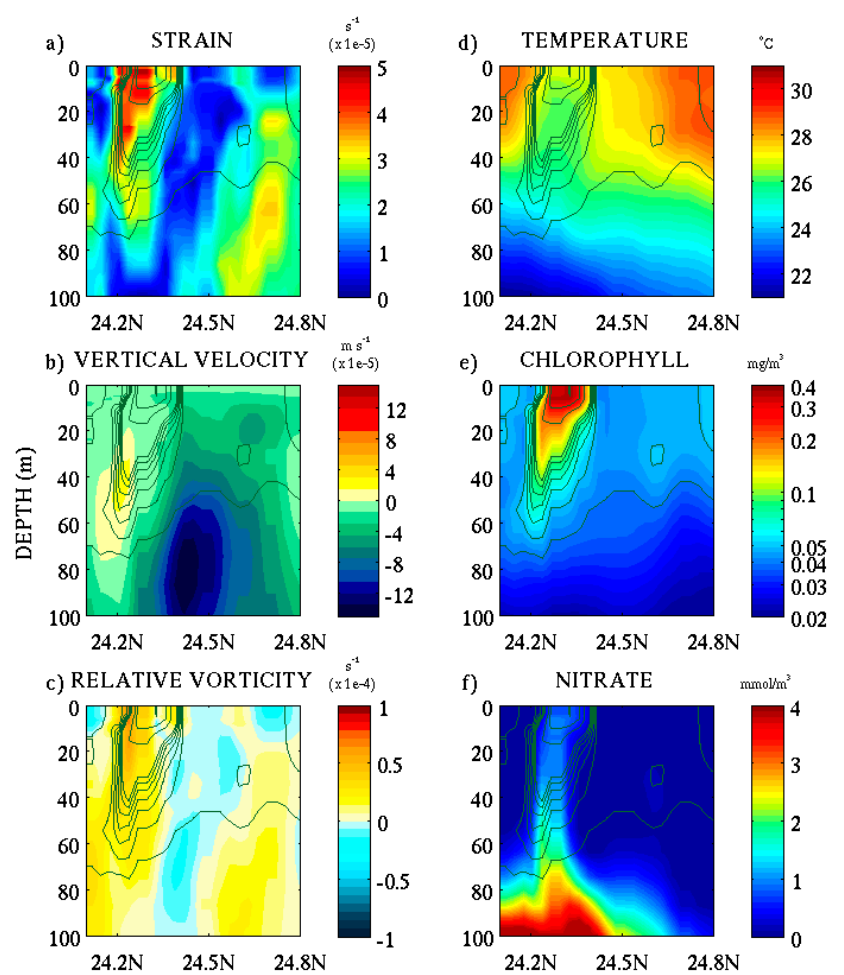
Figure 9. Simulated filament cross-section view (~89.6 ° W), outer filament edge 21 September 2004: ( a ) strain rate (s − 1 ); ( b ) vertical velocities (m s − 1 ); ( c ) relative vorticity (s − 1 ); ( d ) temperature ( ◦ C); ( e ( a ) strain rate (s − 1 ); ( b ) vertical velocities (m s − 1 ); (c) relative vorticity (s − 1 ); (d) temperature ( ° C); ( e) chlorophyll (mg m − 3 ); (f) nitrate (mmol N m − 3 ). Chlorophyll concentration contours are overlain on